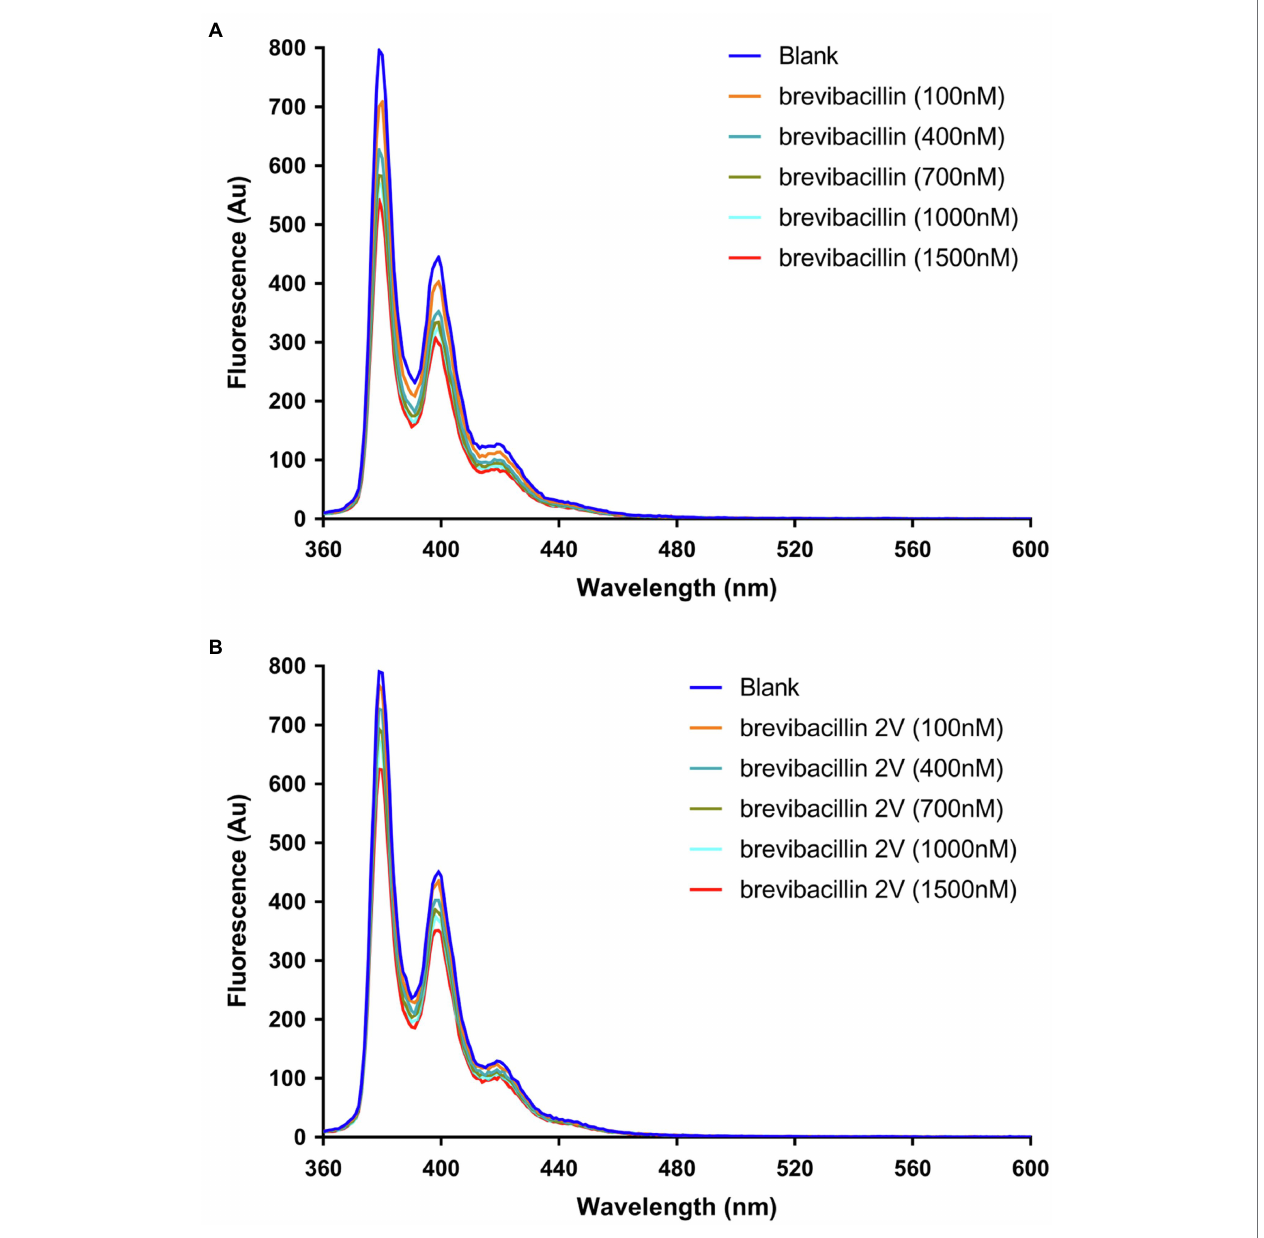
FIGURE 6 | Brevibacillins quench the fluorescence of pyrene-labeled Lipid II. (A) , Effect of increasing brevibacillin concentrations on the fluorescence characteristics of pyrene-labeled Lipid II at 0.5 mol % in DOPC bilayers. (B) , Effect of increasing brevibacillin 2V concentrations on the fluorescence characteristics of pyrene- labeled Lipid II at 0.5 mol % in DOPC